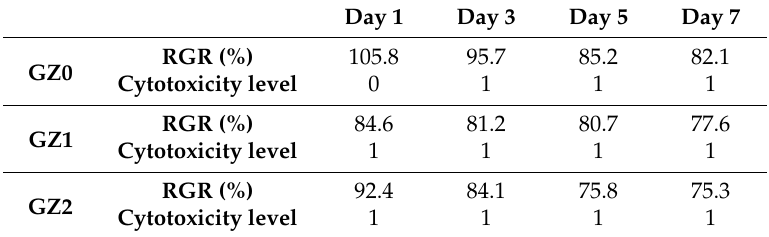
Table 1. The relative growth rate (RGR) and cytotoxicity level of GZ0, GZ1 and GZ1.